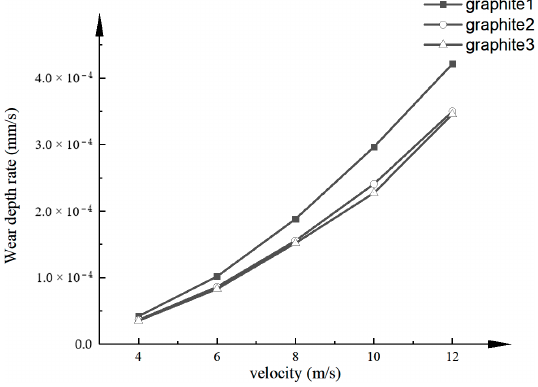
Figure 17. Depth of wear rate versus flow rate line graph.